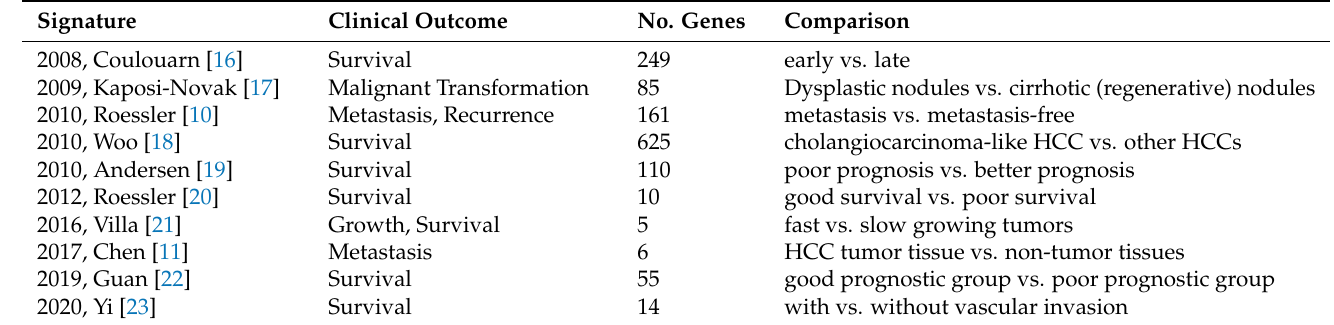
Table 1. Ten selected HCC gene signatures for